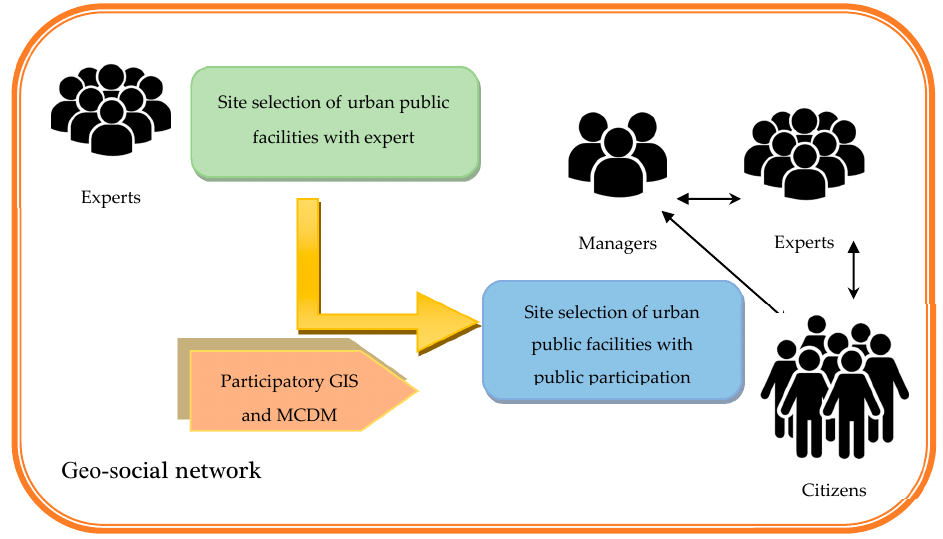
Figure 1. Collaborative decision making for public urban site selection.